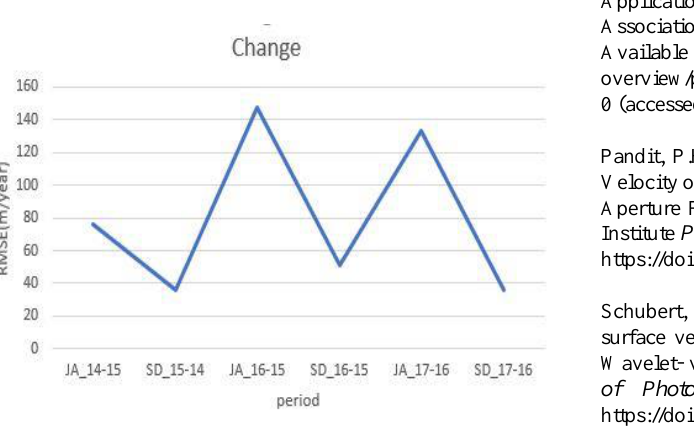
Figure 2 . Graph showing spatiotemporal changes in